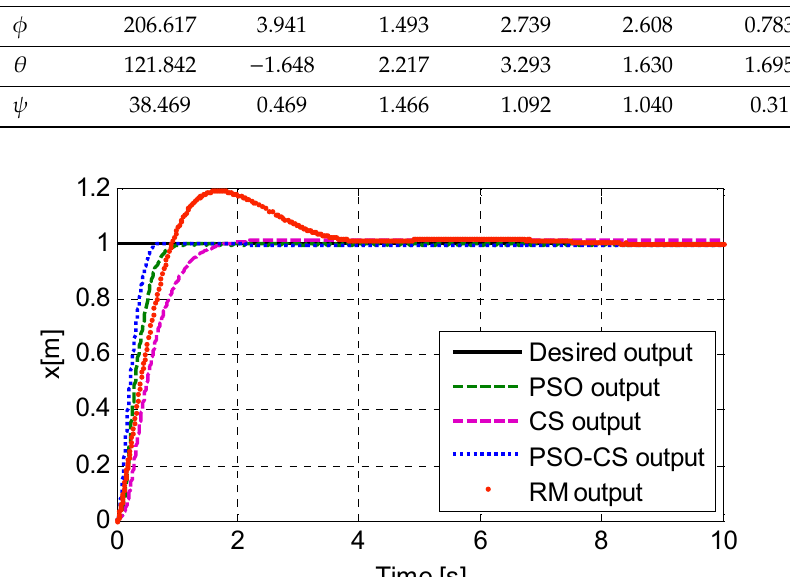
Figure 3. Quadrotor’s position x using Particle Swarm Optimization (PSO), Cuckoo Search (CS), Particle Swarm Optimization-Cuckoo Search (PSO-CS), and Reference Model (RM).